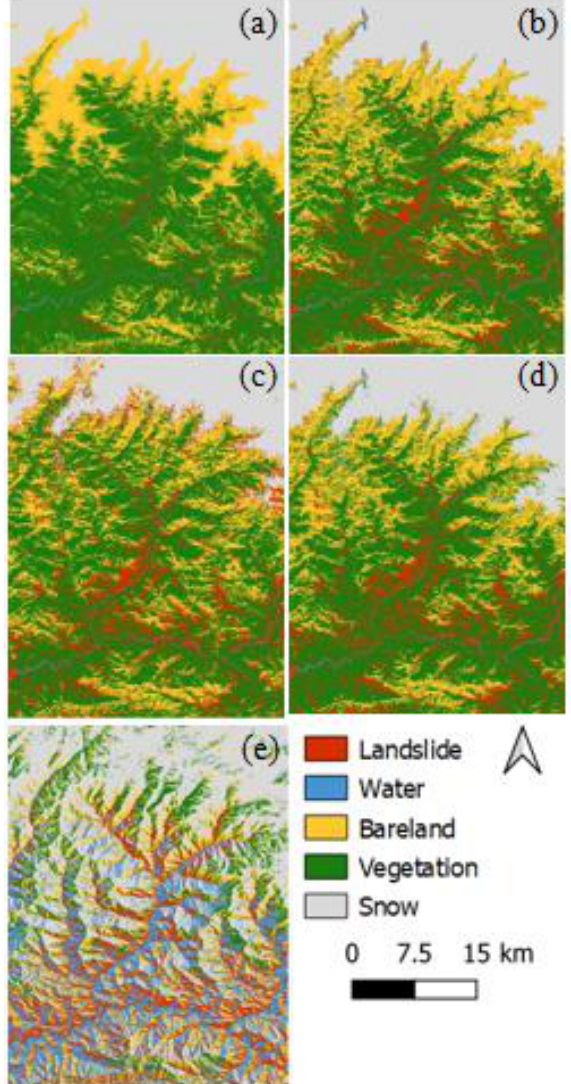
Figure 6. Classification of the study area by (a) SVM, (b) CART, (c) Minimum Distance, (d) Random Forest, (e) Naïve